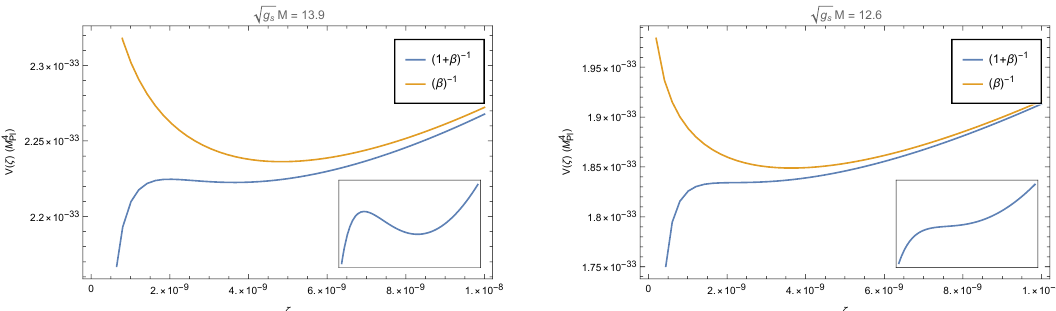
Figure 4. Plotting the potential (3.5) for two different choices of the flux M , with all other parameters fixed at Ω 2 = 8 , Λ 0 = 10 2 , K = 1 , g s = 0 . 1 , V = 10 15 , in a regime with β (cid:29) 1 . Note